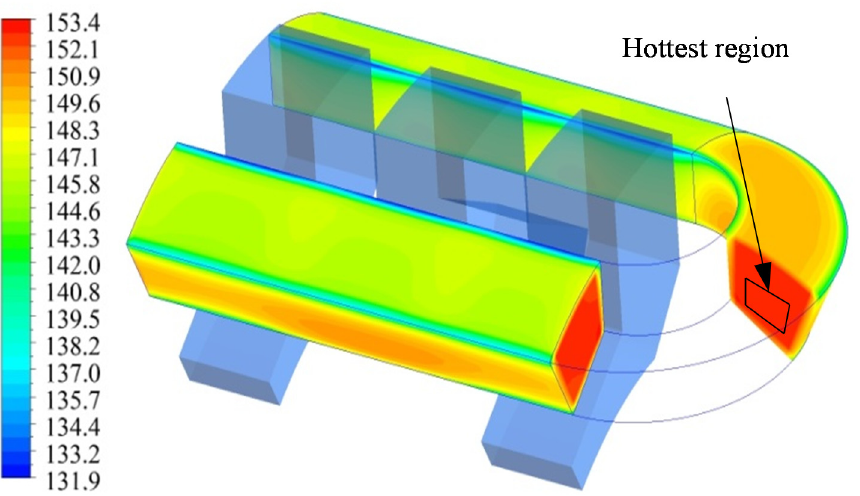
Figure 11. Temperature field distribution of the stator winding (in